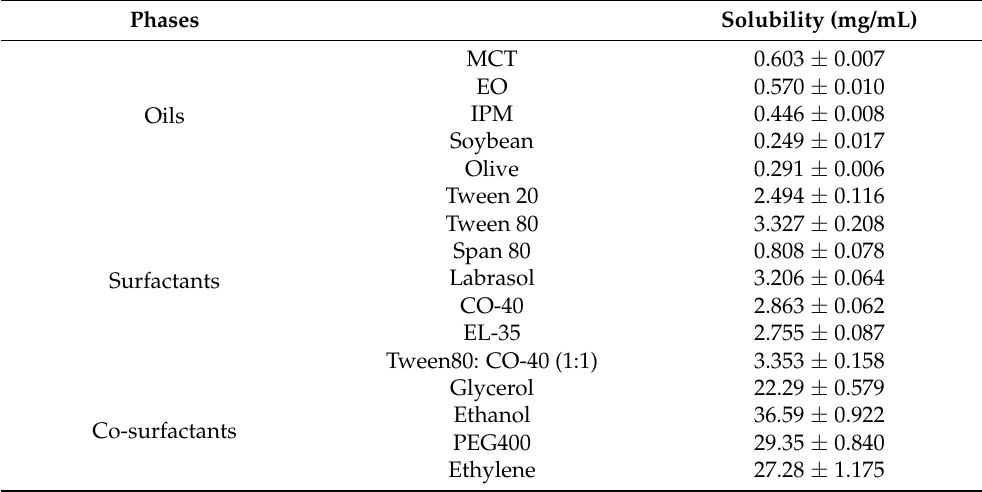
Table 1. Solubility of genipin in different oils, surfactants, and co-surfactants.